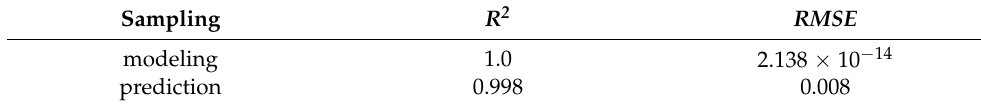
Table 5. Precision factors of GP model.